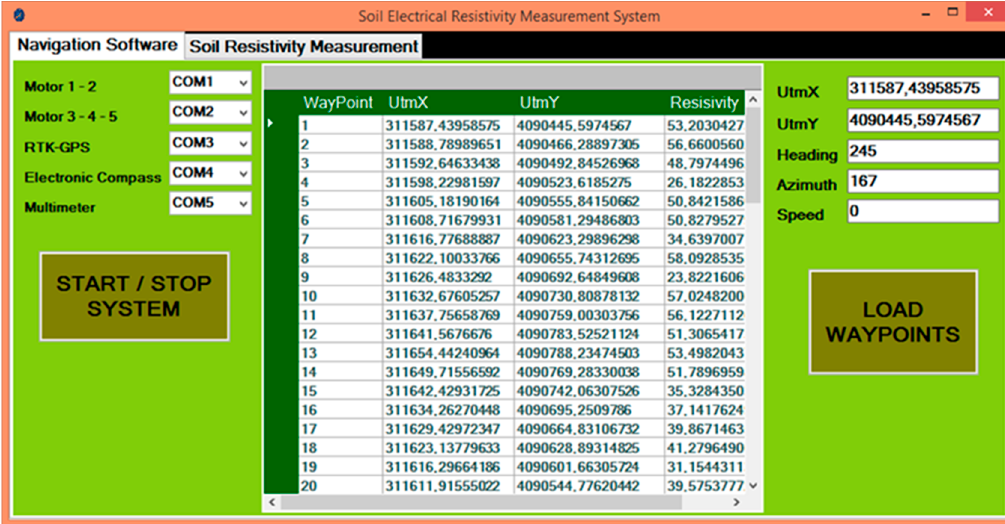
Figure 5. Navigation software.